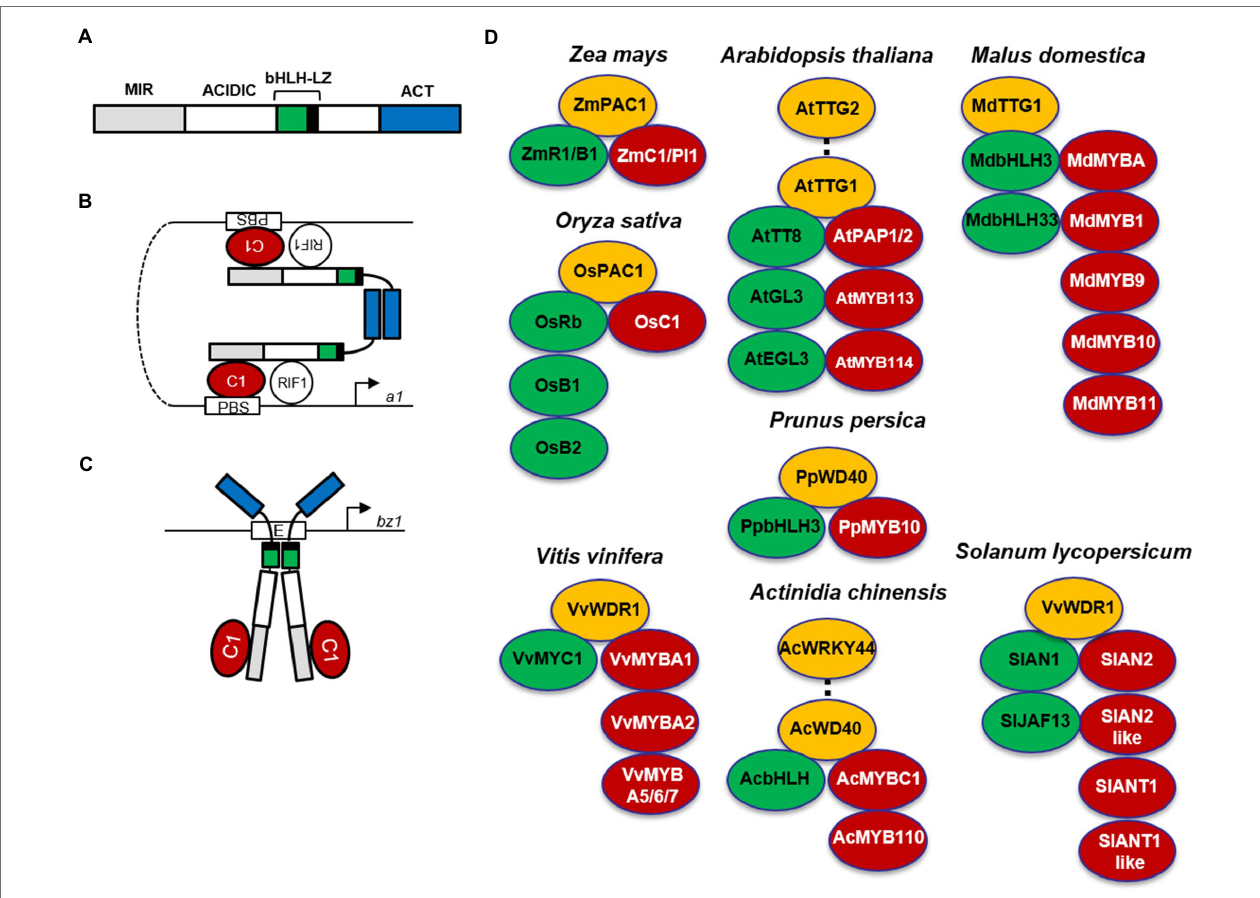
FIGURE 2 | MBW complexes in different plant species. Alternative R1/C1 complexes activating anthocyanin biosynthesis genes in maize. (A) Schematic representation of the R1 functional domains. MIR, MYB interacting region; ACIDIC, acidic region; bHLH, basic helix-loop-helix domain; LZ, leucine zipper; ACT, ACT- like domain. (B) In the first R1/C1 complex, R1 homodimerizes via the ACT-like domain, the bHLH region of R1 interacts with R-interacting factor 1 (RIF1), and the N-terminal acidic region interacts with C1, which binds the P1-binding sites (PBS) found in promoters of some anthocyanin biosynthesis genes, such as a1. (C) In the second R1/C1 complex, R1 homodimerizes via the bHLH-LZ domain, which binds E-box elements, such as those present in the bz1 promoter, and interacts with the C1 protein, providing a strong transcriptional activation domain. (Schemes modified from Kong et al., 2012). (D) MYB-bHLH-WD40 (MBW) complexes involved in anthocyanin biosynthesis in different plant species. MYBs are indicated in red, bHLHs in green, and WD40s in yellow. The Arabidopsis MBWW complex (PAP1-TT8-TTG1-TTG2) controlling a subset of proanthocyanidin LBGs is indicated by a dotted line connecting TTG2 and TTG1. The MBWW complex (AcMYBC1- AcbHLH-AcWD40-AcWRKY44) controlling F3 ʹ H and F3 ʹ 5 ʹ H in kiwifruit ( Actinidia chinensis ) is indicated by a dotted line connecting